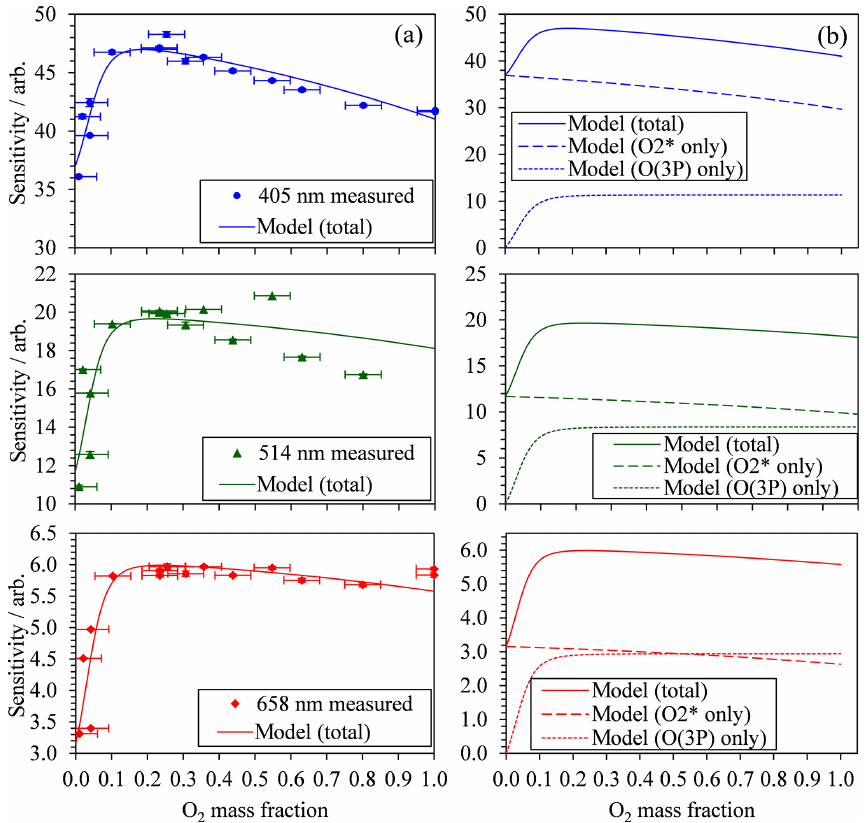
Figure 3. (a) The measured PAS sensitivity C with variation in the bath gas O 2 mass fraction (points) and best fit descriptions of the data for the model described by Eqs. (8), (11) and (12). The measured data include vertical error bars that represent 1 standard deviation in the measured sensitivity, although these error bars are not visible on the vertical scale shown. Horizontal error bars represent the uncertainty in O 2 mass fraction arising from the standard errors in the mass flow controller flow rates that control concentrations of O 2 and N 2 in the bath gas. (b) The best fit model description from (a) and the contributions from the two components of the model that correspond to quenching of O ( 3 P ) and O 2 (X 3 (cid:54) − g , v>